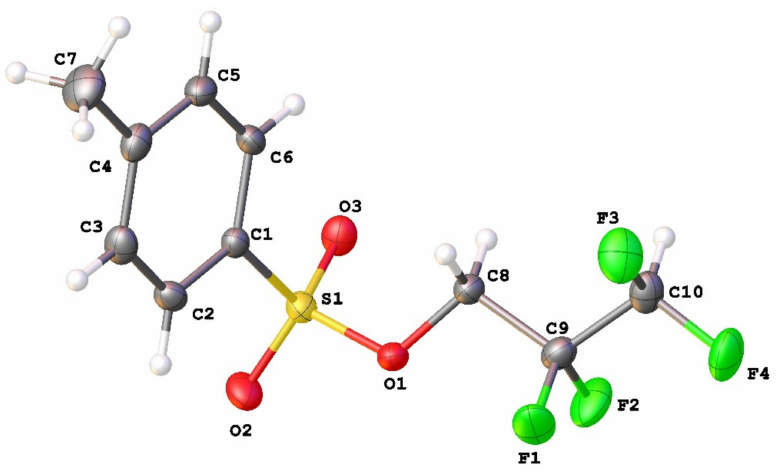
Figure 2. Molecular structure of 2a . Atoms are presented as thermal